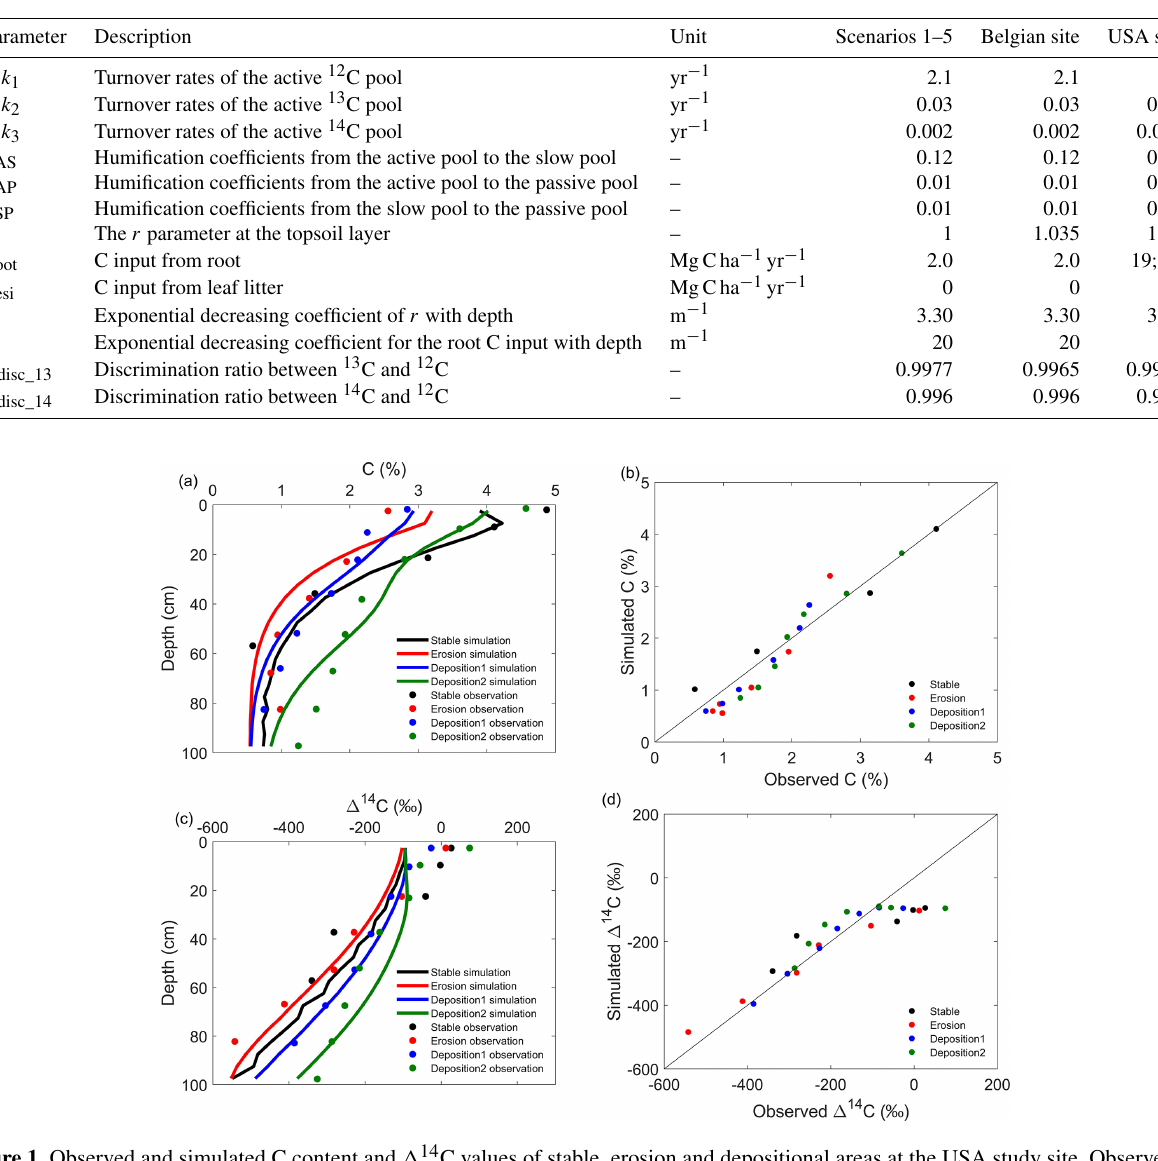
Figure 1. Observed and simulated C content and (cid:49) 14 C values of stable, erosion and depositional areas at the USA study site. Observed and simulated C contents in the format of profiles (a) and 1:1 lines (b) ; observed and simulated (cid:49) 14 C values in the format of profiles (c) and 1:1 lines (d)